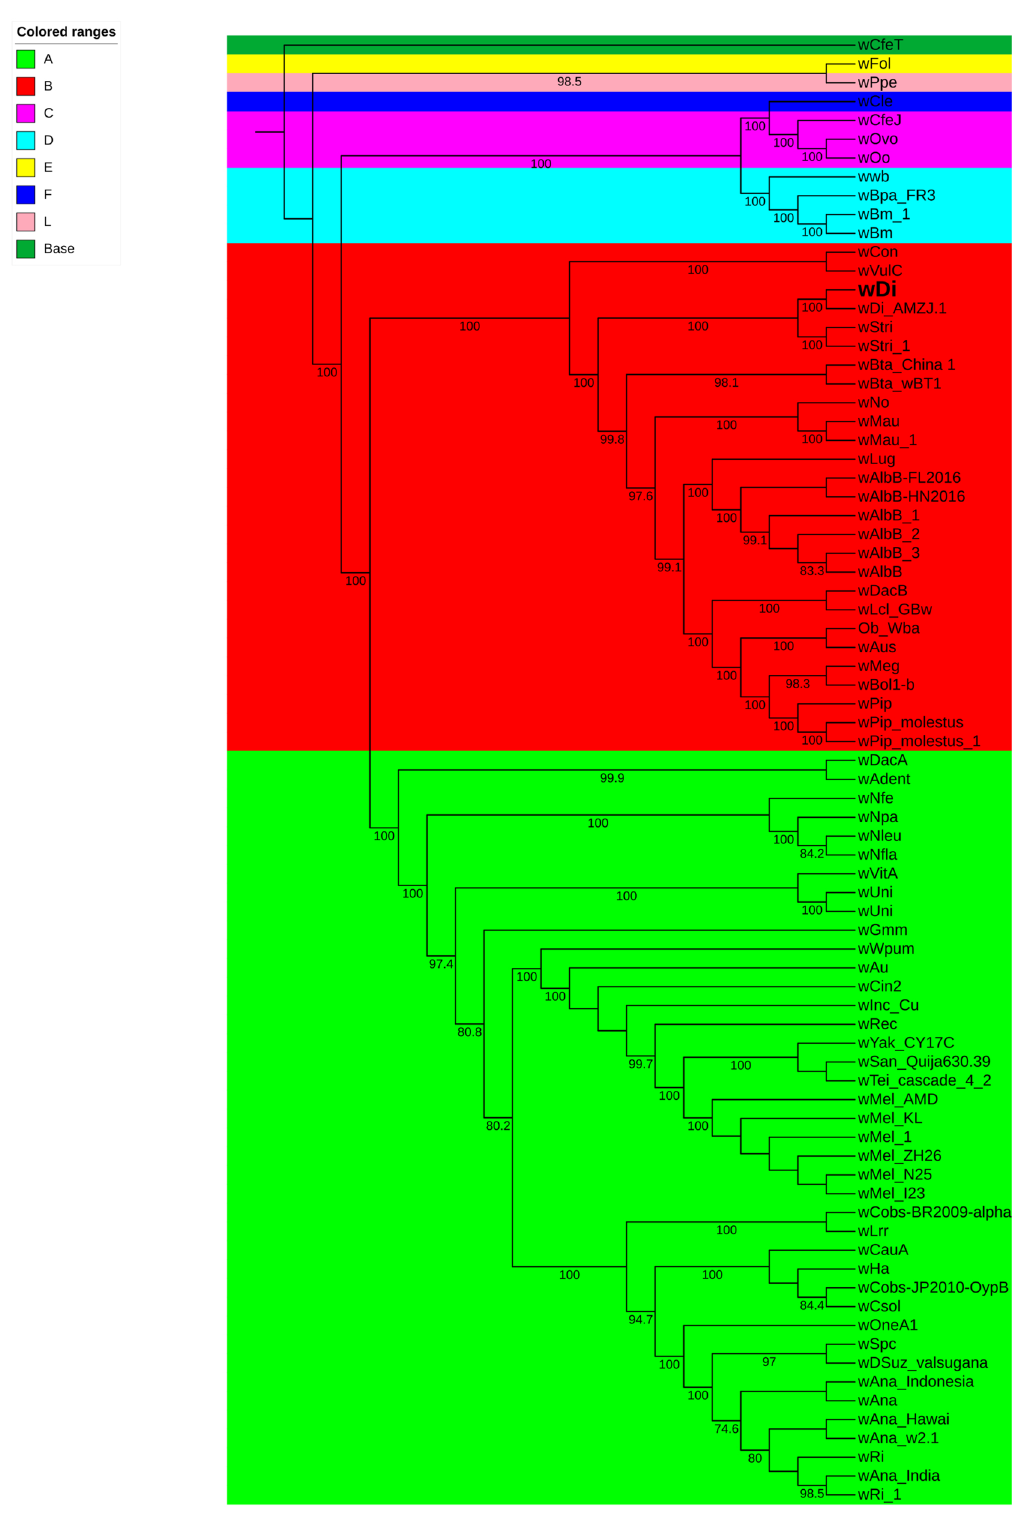
Figure 7. Phylogenetic relationship of Wolbachia genomes using concatenated protein sequences of single copy genes obtained from each genome using hmm source of single copy genes by Campbell et al. 65 . The total of 78 Wolbachia genomes including wDi genome sequenced in this study was used. The maximum likelihood tree was constructed using IQ-TREE v 1.6.8 66 using ultrafast bootsrap mode with 5000 iterations. Branch support was estimated using the Shimodaira–Hasegawa (SH)-like approximate likelihood ratio test with 1,000 replicates. The amino acid substitution model HIVb + F + I + G4 was used and wFol was set as the outgroup. The bootstrap values > 50% are shown at the respective node. The Wolbachia supergroups are color coded which are shown in color